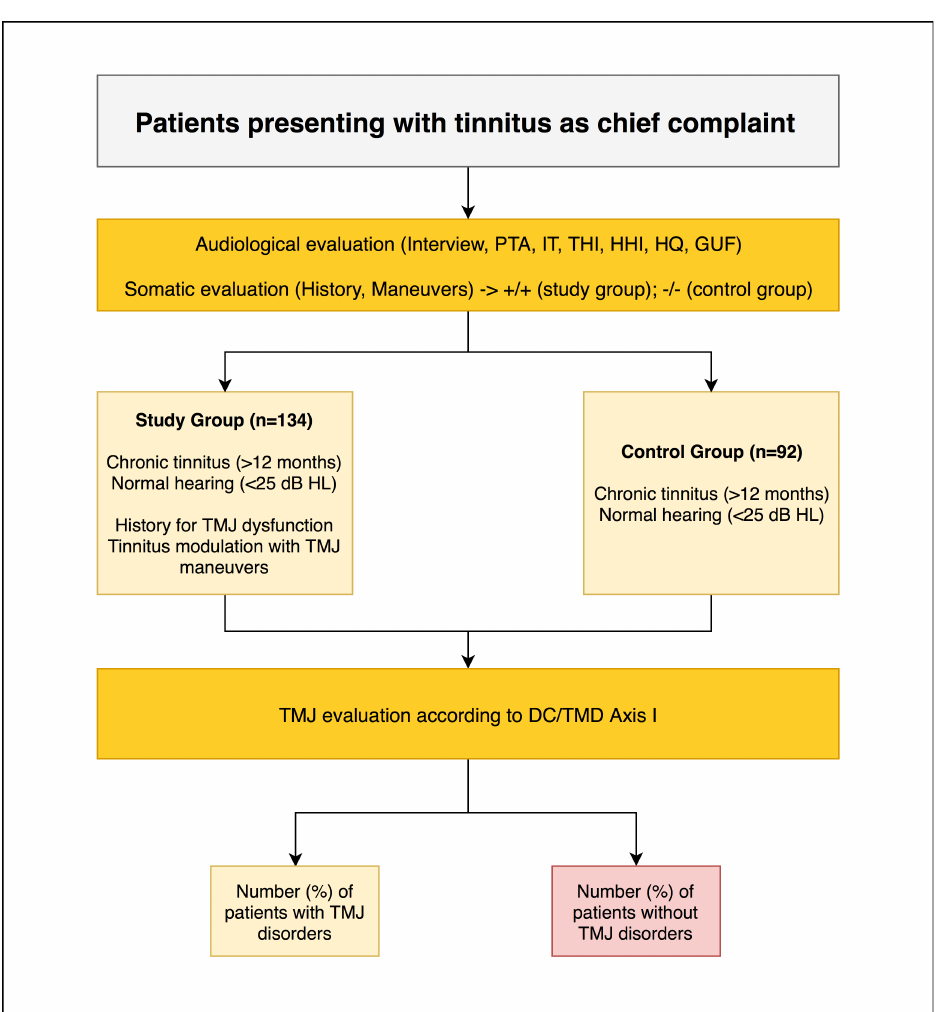
Fig 1. Study workflow for the present study. A total of 226 patients with clinically normal hearing and chronic tinnitus were enrolled in the study and underwent audiological and somatic evaluation. Patients were divided into a study group (n = 134) and a control group (n = 92) based on self-reported history of temporomandibular (TMJ) dysfunction and positive somatic modulation of tinnitus following somatic maneuvers in the TMJ region. Afterwards, all patients underwent gnathological evaluation to assess the presence of clinically diagnosed TMJ disorders according to Diagnostic Criteria for Temporomandibular Disorders (DC/TMD) Axis I. PTA: Pure Tone Audiometry; IT: Immittance Test; THI: Tinnitus Handicap Inventory; HHI: Hearing Handicap Inventory; HQ: Hyperacusis Questionnaire; GUF: Gera¨uschu¨berempfindlichkeit